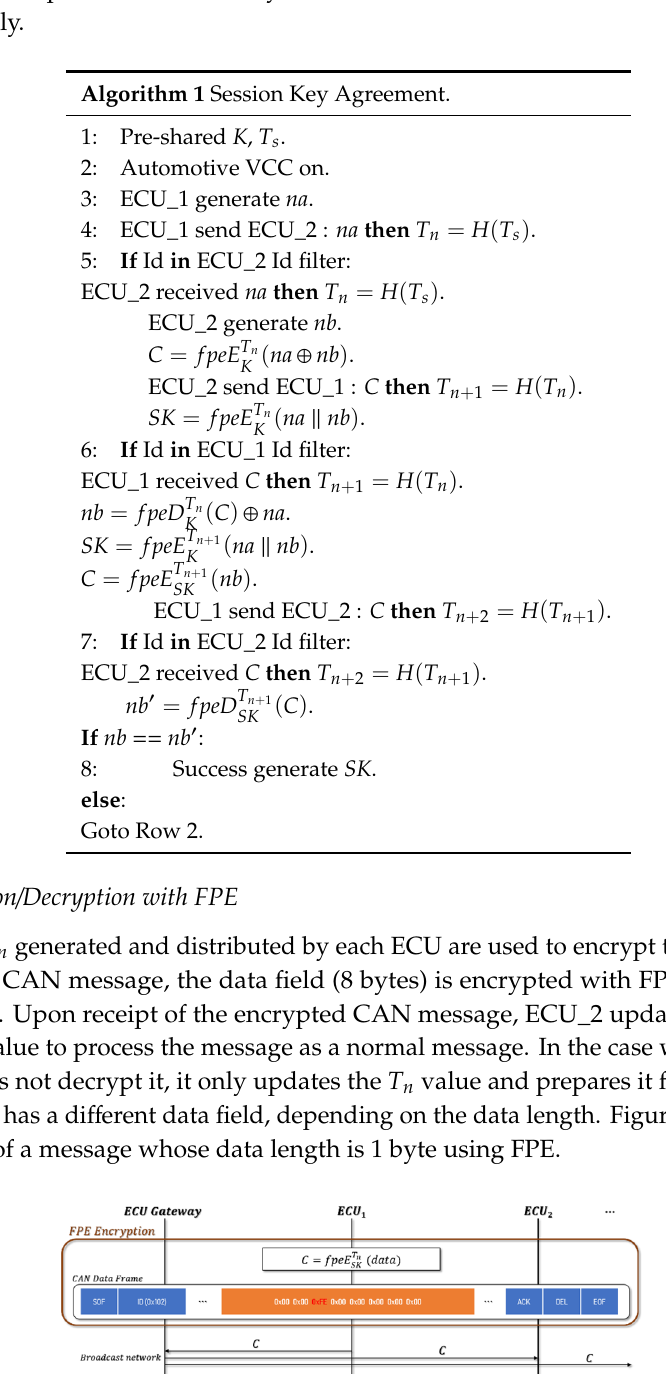
Algorithm 1 Session Key Agreement.